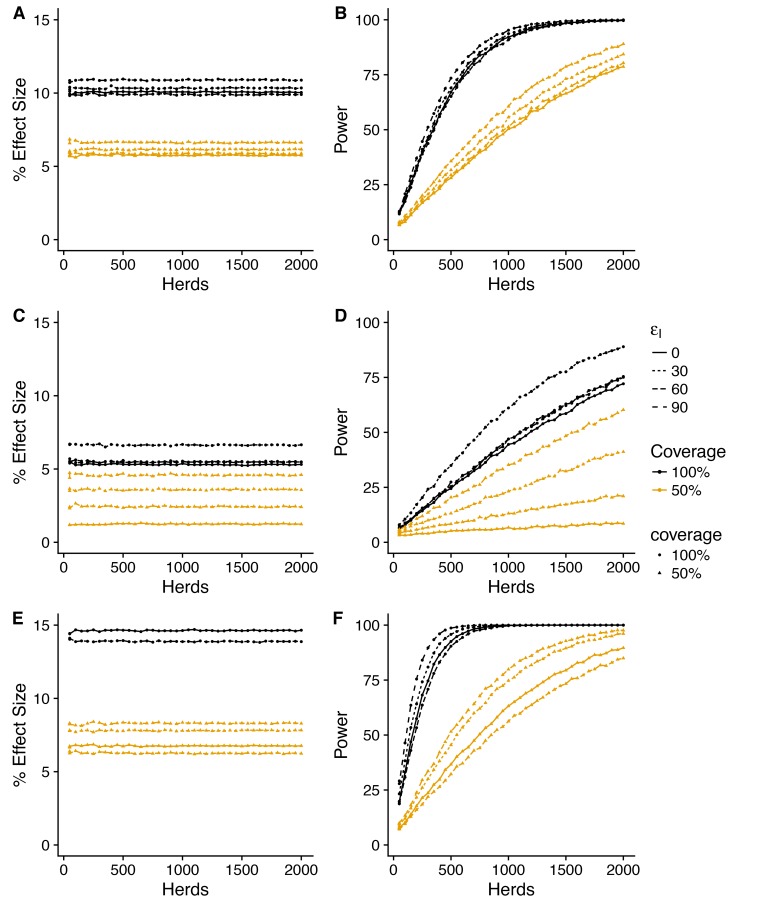
Predicted effect of vaccination on probability of recurrence (SOR model).Simplest design to measure vaccine effectiveness with 50:50 mix of control and vaccinated herds and a target coverage of either 50 or 100% for a 3-year trial period. We explore a range of assumed vaccine-induced reductions in susceptibility (A,B) εS=60%(C,D) εS=60%(E,F) εS =90% and infectiousness (εI = 0, 30, 60, 90%). For an assumed vaccine efficacy of 90% (reduction in susceptibility), the SOR model predicts a ~ 15% reduction in prolonged breakdowns (defined as the proportion of herds that take more than 1 short interval test to clear restrictions) for 100% vaccination coverage and ~ 5% for 50%. For this effect size, ~ 300 herds would be required to achieve the target 80% trial power for whole herd vaccination. In excess of 2000 herds (the upper range considered) would be required for a 50% within herd target coverage.